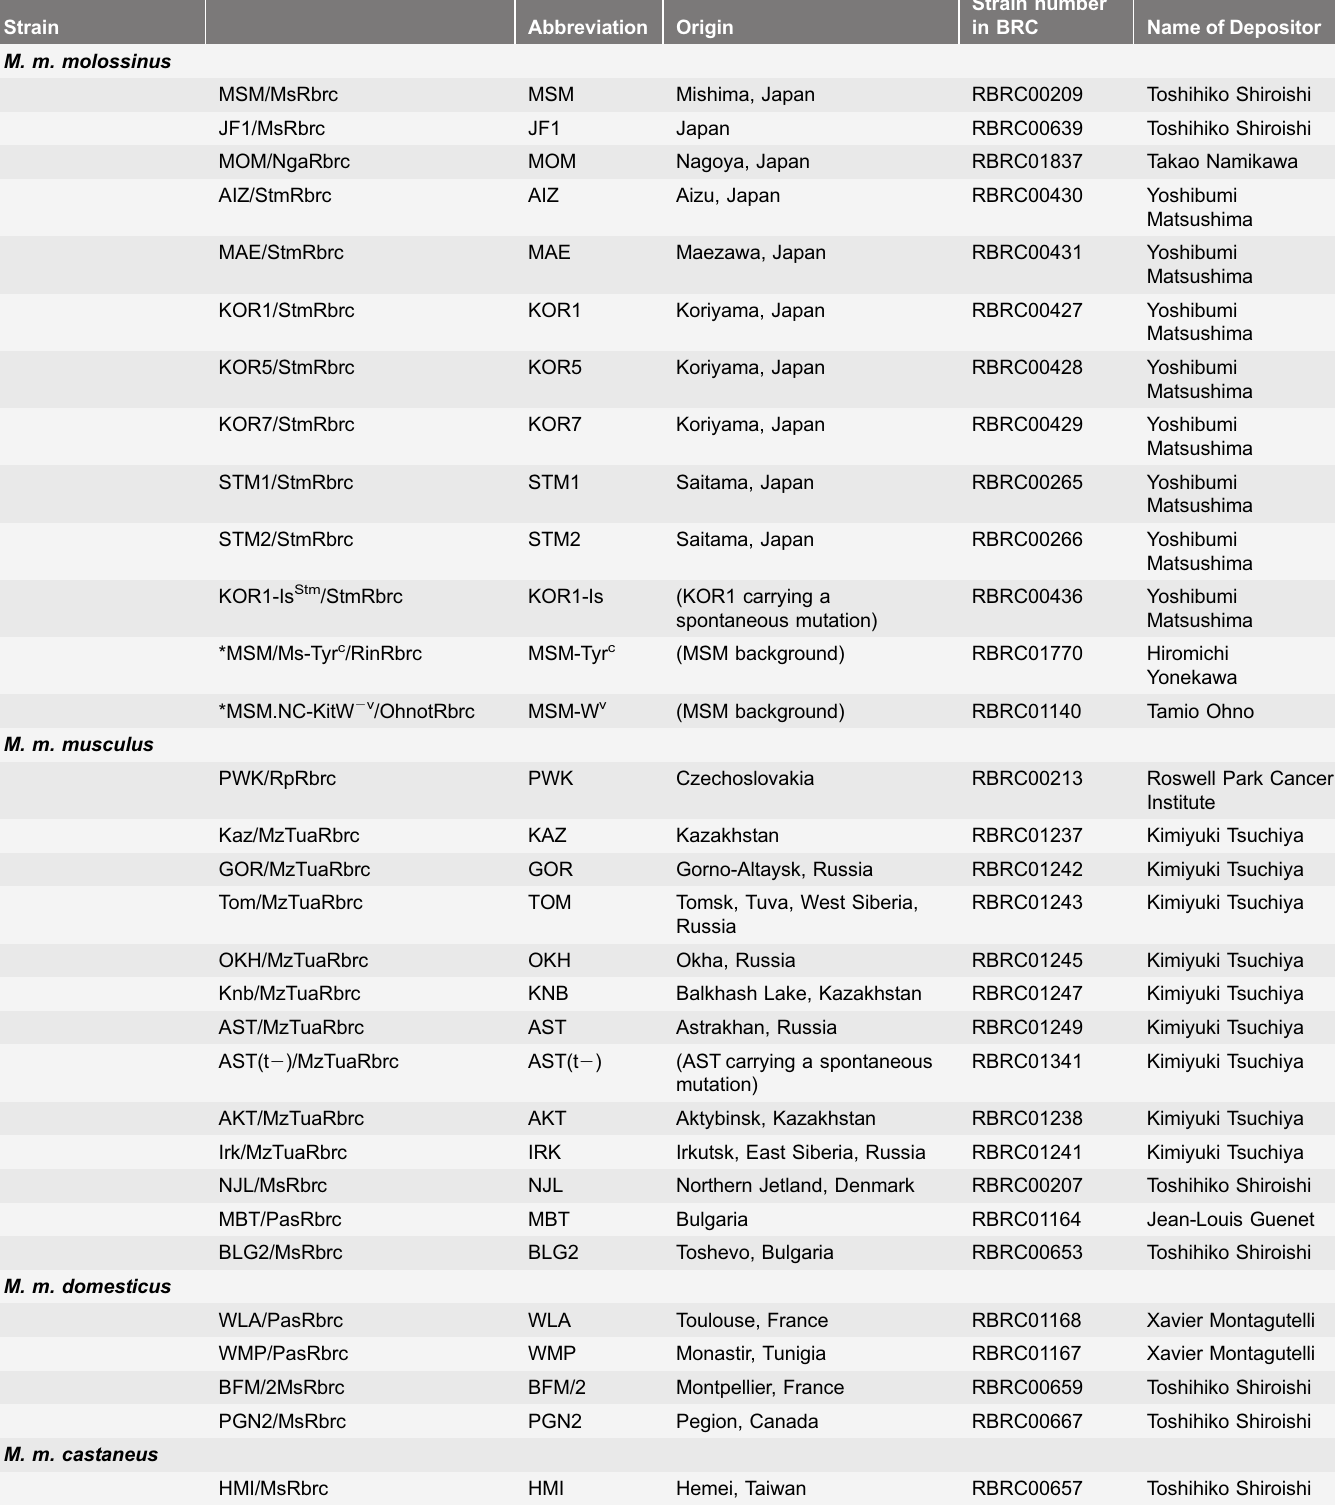
Table 1. List of the strain name and the origin in wild-derived strains.